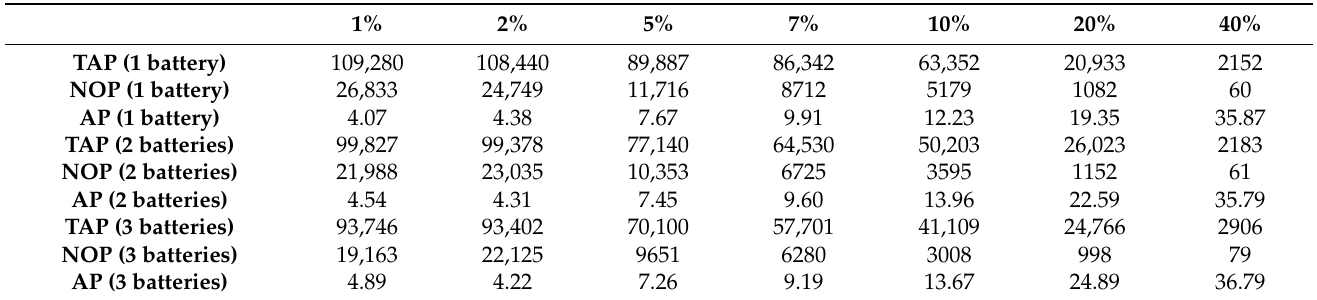
Table 7. Main statistics of the Total Amount of Penalty (TAP) in EUR, Number of Penalties (NOP) and Average Penalty (AP) in EUR obtained for each ramp-rate limitation considering all the 10-year